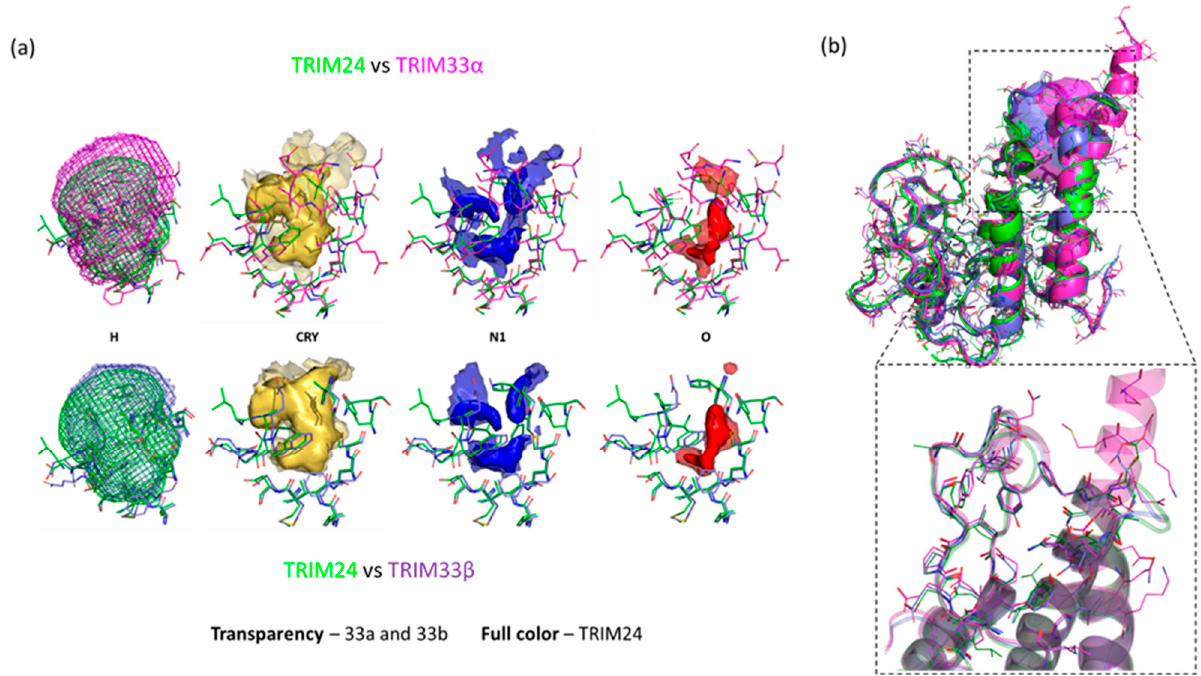
Figure 2. ( a ) Representation of the cross-relationship results between TRIM24 (residues in green and MIFs in transparency), TRIM33 α (residues in magenta and MIFs in full colour), and TRIM33 β (residues in purple and MIFs in full colour) pocket. The overlapped GRID MIFs are contoured and coloured in the following manner: H (shape) at 0.10 kcal/mol and coloured according to the relative residues, CRY (lipophilic features) in yellow at − 0.6 kcal/mol, N1 (donor features) in blue at − 4.5 kcal/mol and O (acceptor features) in red at − 3.5 kcal/mol. ( b ) Aligned structures and pockets (TRIM24 PDB code: 4yat [42] in green, TRIM33 α PDB code: 3u5o[39] in magenta, and TRIM33 β PDB code: 5mr8 [36] in violet) pre-processed with BioGPS [30] with a zoomed view into the KAc binding region.